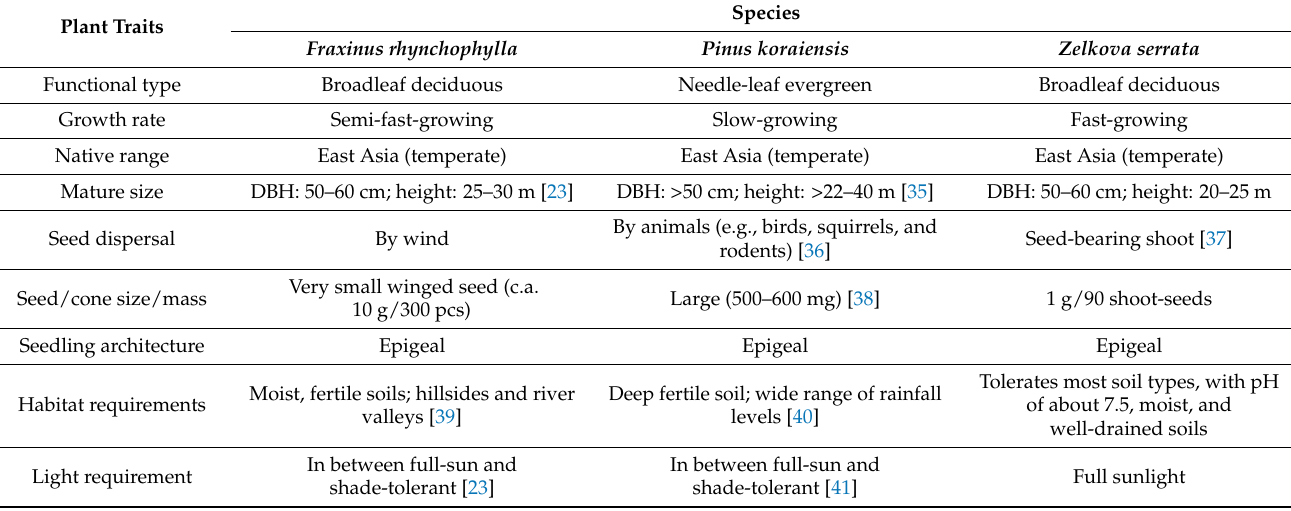
Table 3. Contrasting life-history/ecological traits of Fraxinus rhynchophylla , Pinus koraiensis , and Zelkova serrata